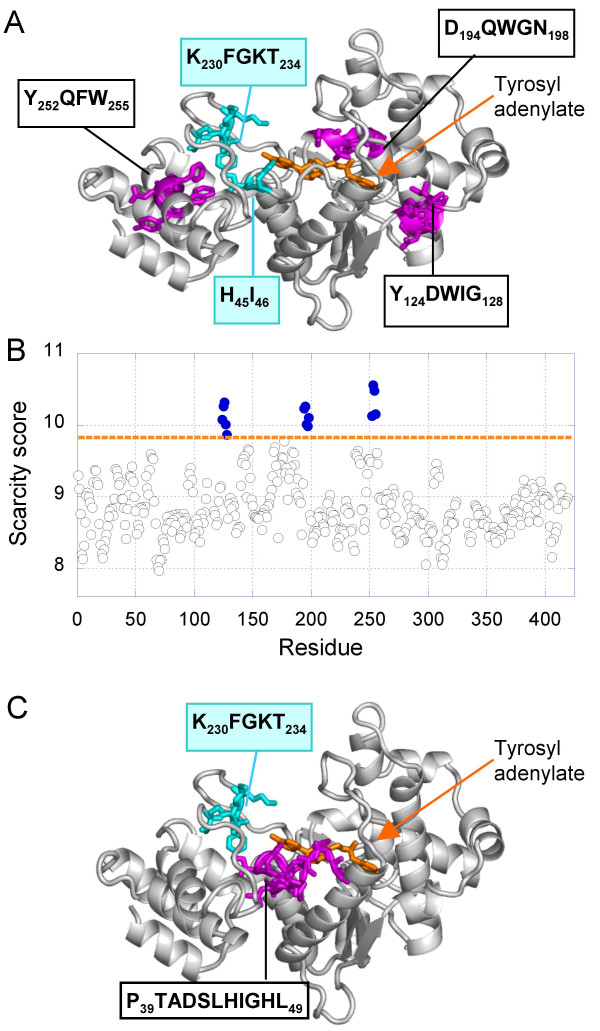
(A) Identification of tyrosyl tRNA synthetase unique n-grams. Tyrosyl -tRNA synthetase (PDB:3TS1 [48]) is shown (white) in complex with tyrosyl adenylate intermediate (orange). The pair H45I46 (cyan) of the catalytic His, the residues K230FGKT234 of the mobile loop (cyan) and the three most unique n-grams (magenta) are shown as sticks.(B) Scarcity score of amino acids. 24 homologous (E value < 10-57) of Bacillus stearothermophilus were used to calculate the average uniqueness score. Three unique n-grams (filled circles) are distinguished. (C) PROSITE motifs. The loop containing the catalytic His at the binding site (magenta) is identified using PROSITE.